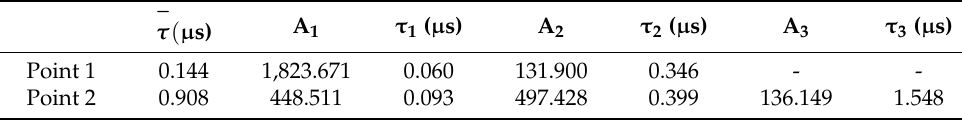
Figure 9. Time-resolved luminescence measurement at two different points of the CPI3-10 h sample; λ exc = 500 nm. λ exc = 500 nm. Table 3. Fit parameters of TR-photoluminescence measurements. Table 3. Fit parameters of TR-photoluminescence